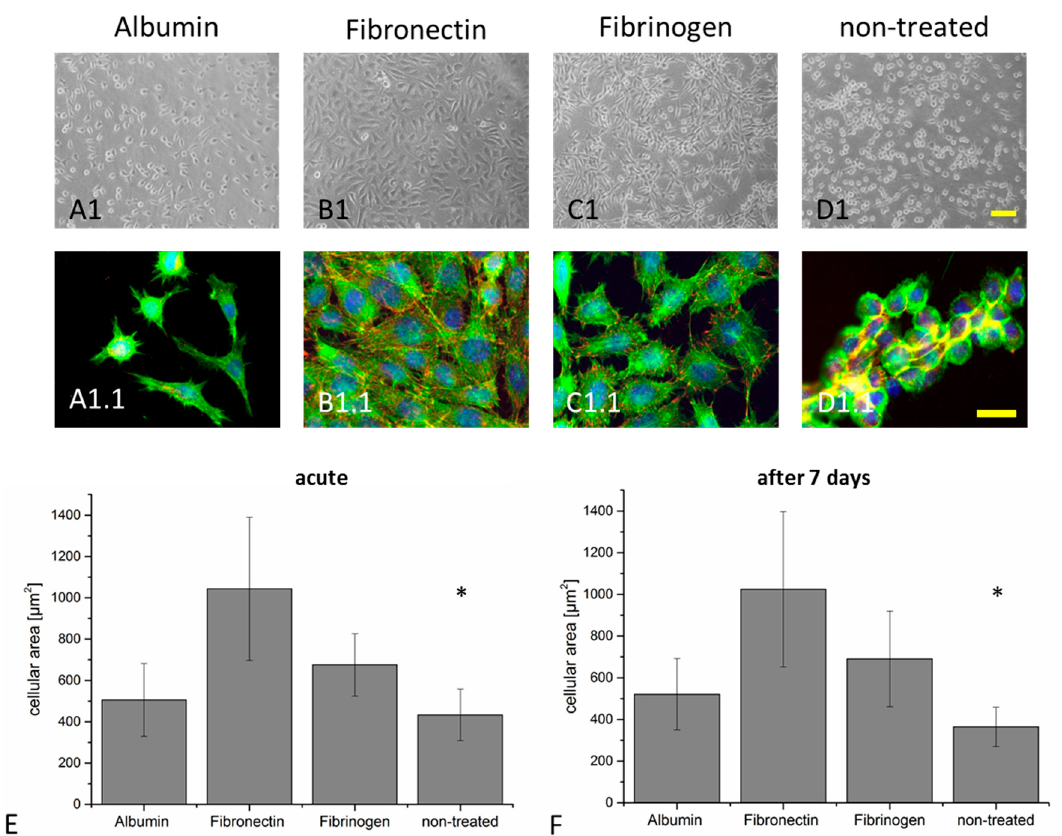
Figure 3. Cellular response to the protein coating on the elastomer films. L929 murine fibroblasts were cultured on SSA films coated with albumin ( A1 , A1.1 ), fibronectin ( B1 , B1.1 ), fibrinogen ( C1 , C1.1 ), and non-treated (pristine) polymeric surface ( D1 , D1.1 ). Phase contrast pictures were acquired after a culture period of 48 h ( A1 , B1 , C1 , D1 ). Additionally, the cells were stained with an anti phospho-FAKTyr 397 antibody to visualize focal adhesion contacts (red). The actin cytoskeleton (green) and cellular nuclei (blue) were stained ( A1.1 , B1.1 , C1.1 , and D1.1 ). Cellular spreading was determined on films that have been directly used for cell culture ( E ) and on films stored for seven days in ddH 2 O at 37 °C before seeding the cells ( F ) (see also Figure S3). Number of independent experiments: n = 3 for the fluorescence analysis; n = 4 for the determination of the cellular area. Scale bar in A1, B1, C1, D1 = 100 µm; scale bar in A1.1, B1.1, C1.1, D1.1 = 25 µm. At a specific time point, statistically significant differences were detected between all conditions. Furthermore, no significant difference could be detected while comparing both time points (acute versus seven days, indicated by an asterisk, p ≤ 0.05).